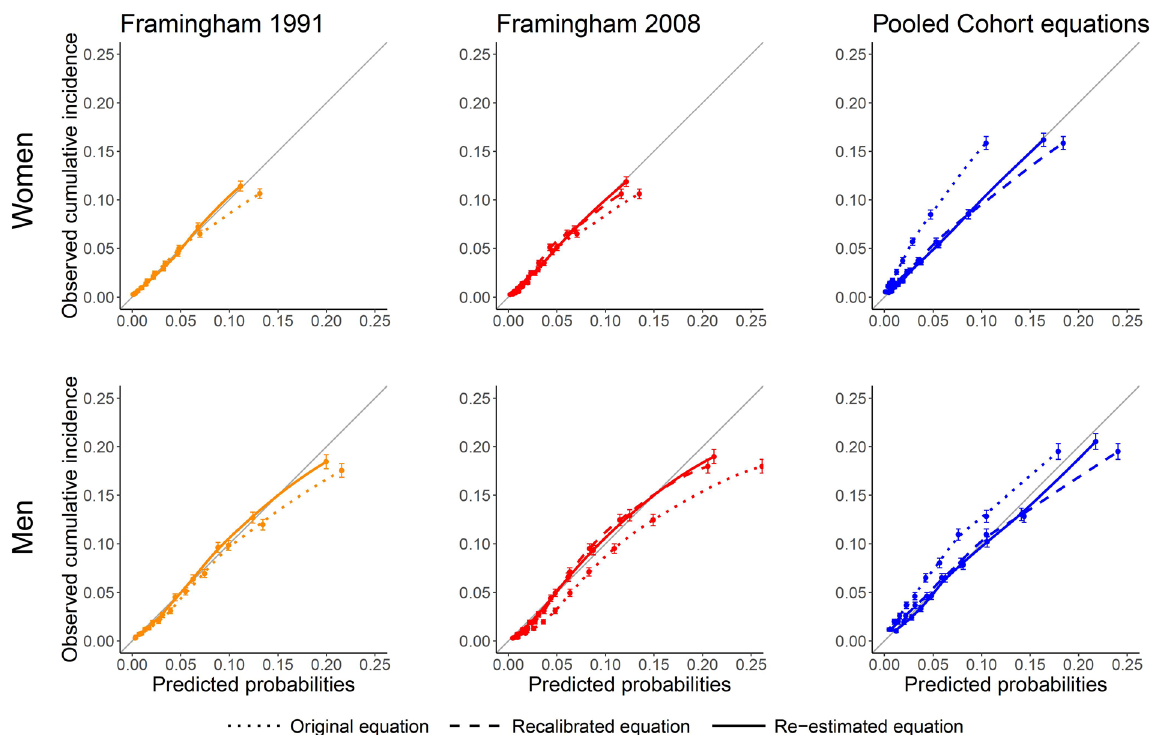
Figure 3. Calibration plots for the five-year CVD risk for women and men. Error bars represent 95%-confidence intervals. Dotted lines visualize predictions from the original equations, dashed lines show predictions from recalibrated equations and continuous lines give predictions from re-estimated equations. In a perfectly calibrated equation, the calibration curve follows the diagonal; a calibration curve above the diagonal indicates underprediction, whereas a calibration curve below the diagonal indicates overprediction. The parametric Framingham 1991 equation cannot be recalibrated. Abbreviations: ASCVD, atherosclerotic cardiovascular disease; CVD, cardiovascular